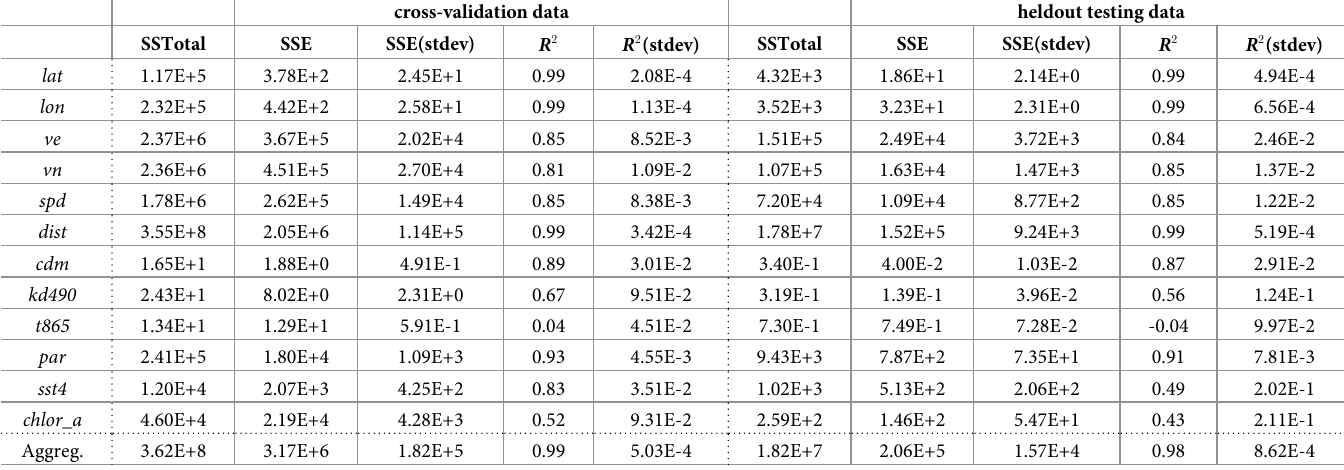
Table 3. R-squared ð R 2 Þ metric for the cross-validation dataset and heldout testing dataset. R 2 is computed for each individual feature and aggregated together for all features. cross-validation